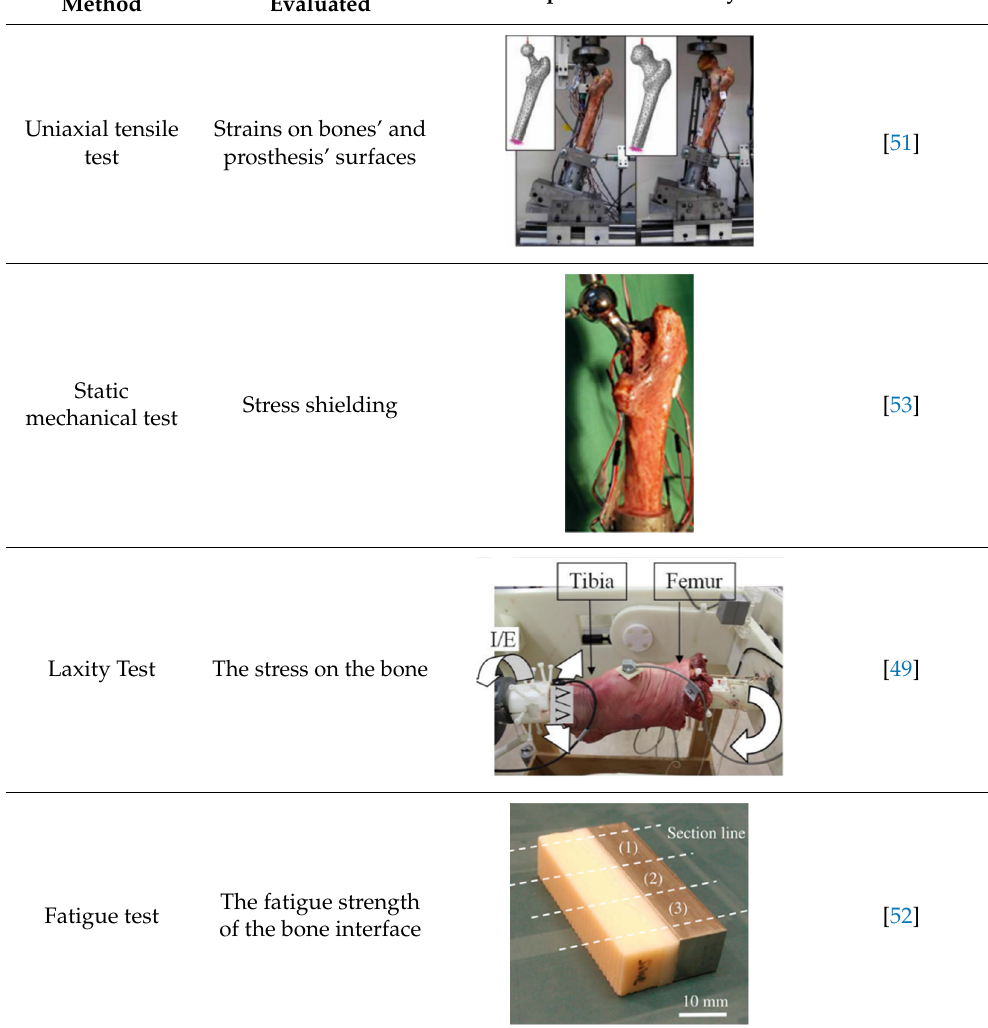
Table 8. The widely used in vivo testing methods for evaluating the performance of bone joint re- placement. Type of Method